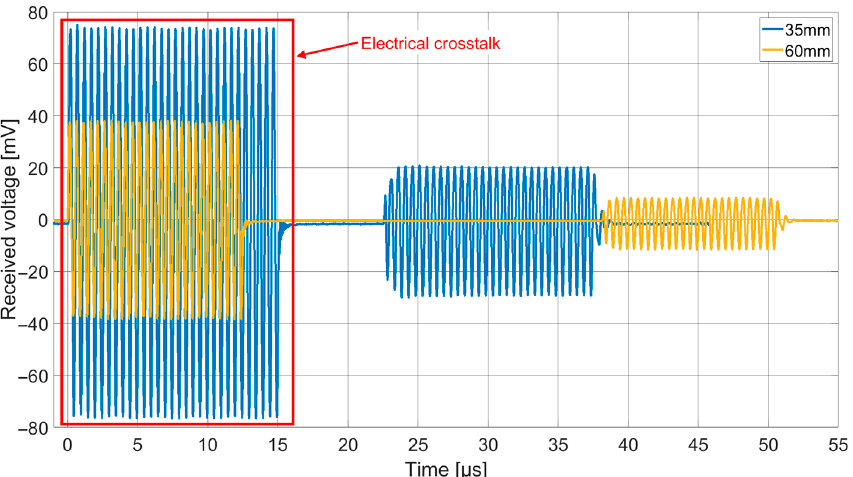
Figure 13. Received signal for the ex vivo transmit experiment at 2 MHz, Chip 2 (170 µ m thick silicone and 25 µ m thick PEEK) for transmitting, Chip 5 (50 µ m thick silicone and 25 µ m thick PEEK) for receiving different transmit depths, 60 V DC , 15 V AC .